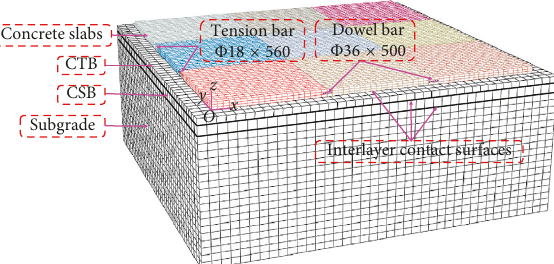
Figure 5: 3-D FE model for test slabs (unit: